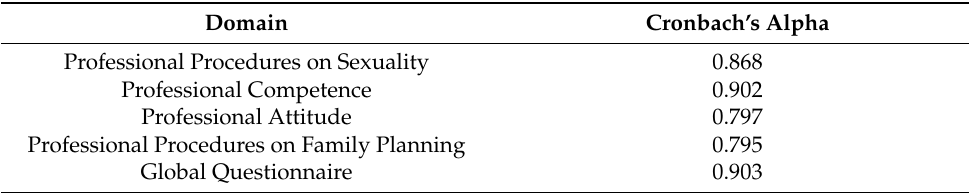
Table 6. Cronbach’s Alpha of the questionnaire and its domains.